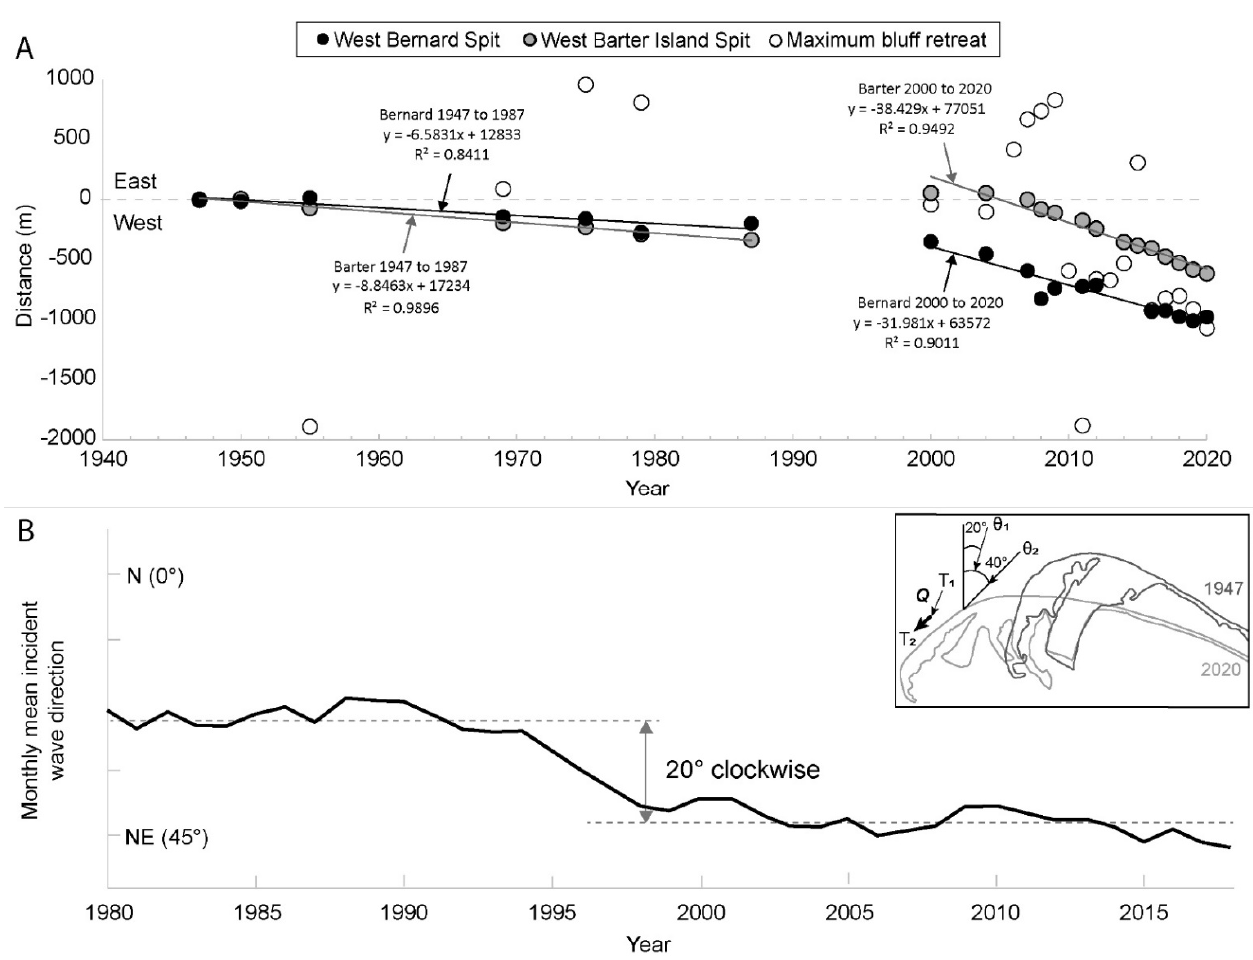
Figure 4. ( A ) Plot showing the cumulative distance of westward migration of the west end of Bernard Spit, the western Barter Island spit, and the transect of maximum bluff retreat from 1947 (spits) or 1950 (bluffs) and 2020. Simple linear regression equations and R 2 values are plotted for two behaviorally similar time periods as observed on the spits: 1947–1987 and 2000–2020; ( B ) Plot of the change in monthly mean incident wave direction at the ERA5 grid cell ~30 km offshore and in 20 m water depth between 1980 and 2019, showing a 20 degree clockwise rotation. Inset plot shows these angles in relation to Bernard Spit.